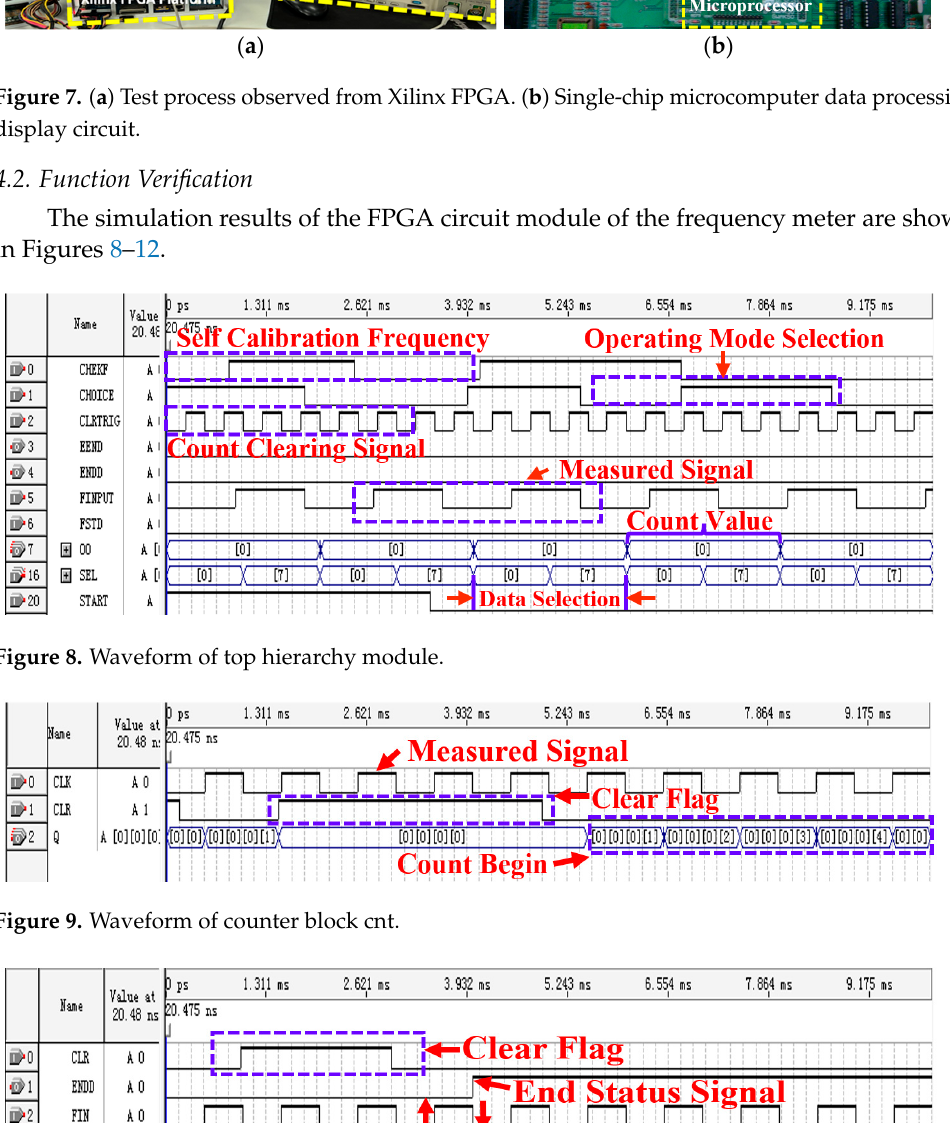
Figure 11. Self-calibration/test frequency selection circuit. Figure 12. Frequency measurement/cycle control circuit. Figure 8 shows the main functions of the frequency meter. Among them, when CLRTRIG = 0, the system is cleared and set. Herein, the CNT is started when the CLRTRIG is at the rising edge, where the pulse width test count is performed until the ENDD fl ips to a high-level count. The selection of self-calibration and frequency measurement modes is determined by the CHOICE signal. FINPUT can be provided by CHKF or FSTD. When START = 0, the counter is closed as a preset gate. When START = 1, the preset gate is opened, and the counter begins to work. Meanwhile, when START = 1 and 0, the positive and negative pulse widths are measured separately to obtain the duty cycle. Finally, SEL reads the selected count value and controls the data entering the microcontroller for pro- cessing and display. Through the choice of working mode in Figure 8, the circuit can be fl exible, switching between self-calibration and frequency modulation modes, thereby im- proving the circuit sensitivity. When the measured frequency meets the requirements, the self-calibration frequency is in a closed state, which is bene fi cial to reduce power con- sumption. Figure 9 shows the work case of the counting module. To initialize the test circuit state, a positive pulse signal is applied to the CLR end of the circuit, resulting in Q becom- ing low. When the CLR is recovered to a negative pulse, the Q-terminal begins to count. This process veri fi es the correctness of the counter circuit and meets the design require- ments.